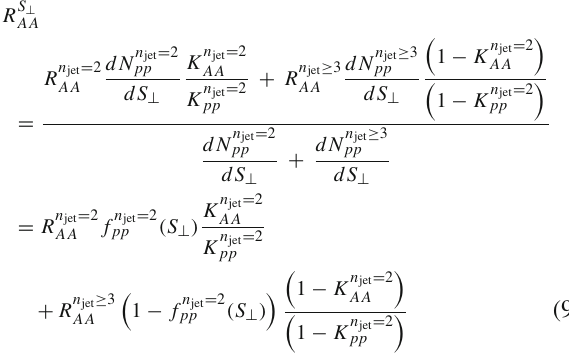
tion proportion of n jet ≥ 3 events in Pb+Pb collisions as jet number reduction